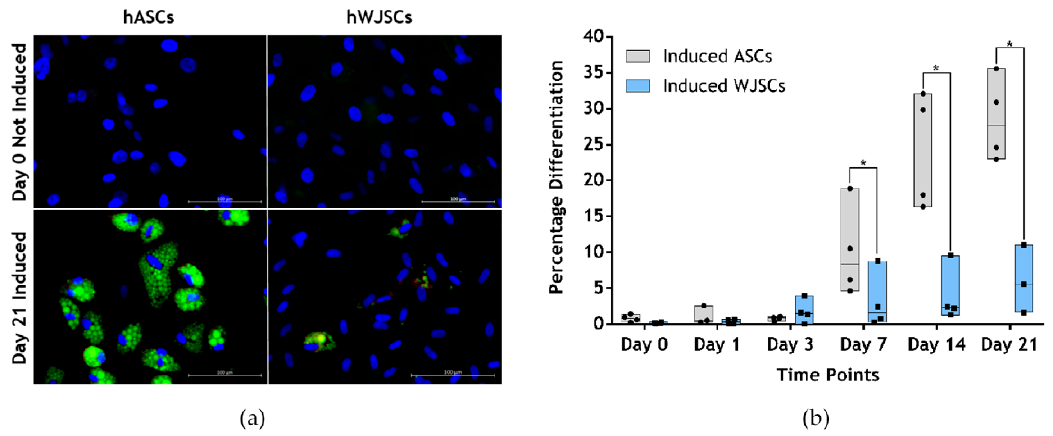
Figure 3. Adipogenic di ff erentiation potential of hASCs and hWJSCs. ( a ) Microscopy images of Day 0 (prior to induction) and Day 21 induced hASCs and hWJSCs. Cells were stained with a nuclear dye Vybrant ® DyeCycle Violet (blue) and a lipophilic dye Nile Red (green). Scale bars: 100 µ m. Magnification: 20 × . ( b ) The percentage of hASCs and hWJSCs that di ff erentiated into adipocytes was determined via a flow cytometric Nile Red assay [62]. Each dot or square within the floating bars represents an independent hASC and hWJSC culture. Four cultures of each were included in the study. The horizontal lines within the bars represent the population median. Statistical significance between the two cell types at the various time points is displayed with an asterisk when * p < 0.05 C. hASCS and hWJSCs displayed the following phenotype: CD36 +/ CD44 +/ CD45- / CD73 +/ CD90 +/ CD105 + (not shown). Unpublished, original data. Table 1. Summary of the adipogenic di ff erentiation potential of MSCs isolated from human tissues. The sources are listed from left to right according to decreasing adipogenic potential observed in the respective studies (direct comparisons).